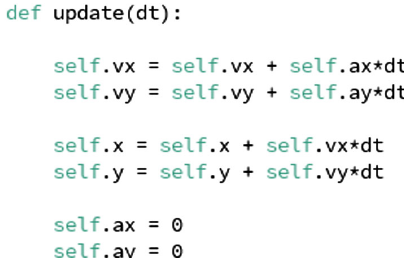
FIG. 6. The implementation of update(dt) avoids the use of vectors or syntax that could make it simpler. The aim of the function is to explicitly show how the attributes are updated during each timestep. During each timestep, new forces are calculated and a net acceleration is obtained, the old acceleration must be removed, to avoid an impetuslike